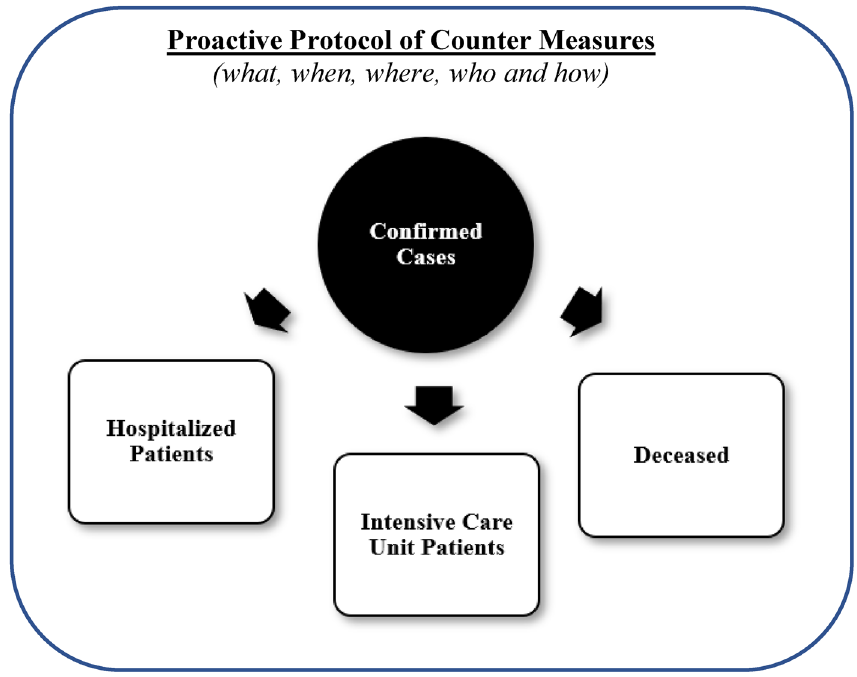
Figure 4. A model estimation and proactive protocol of counter